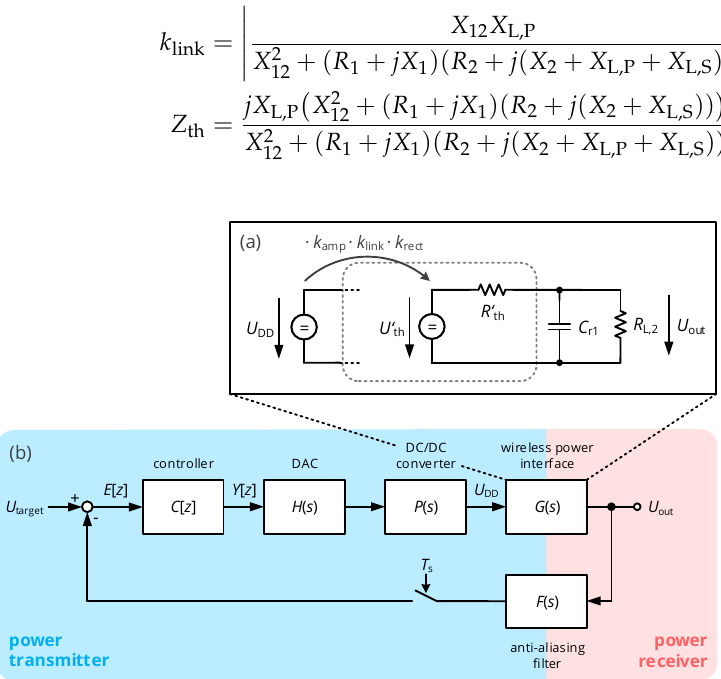
Figure 7. ( a ) DC-domain Thévenin equivalent circuit of the complete wireless power transfer link including class E amplifier, coil interface and rectifier into a simple PT1 element. ( b ) Voltage control loop of the wireless power transfer interface: The interfaces output voltage U out is digitized and provided to a digital controller, which interfaces a primary-side DC/DC converter through a digital- to-analog converter to establish the target voltage U target